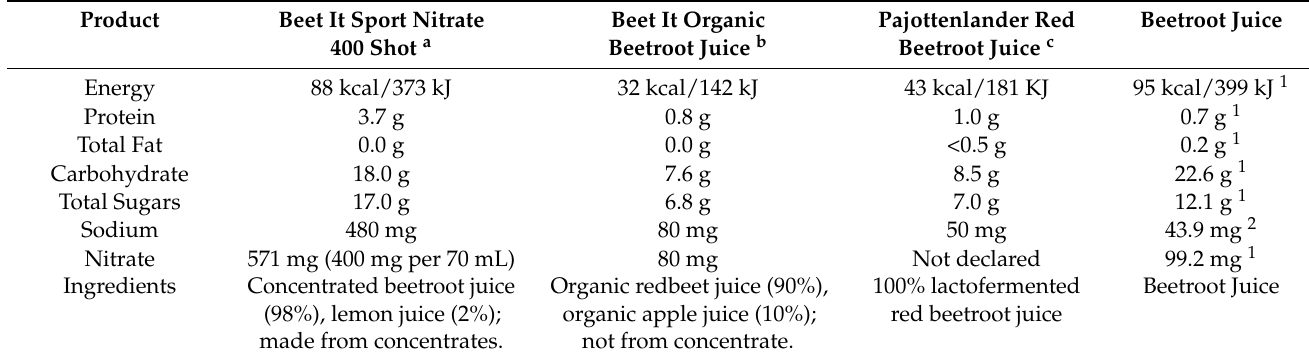
Table 3. Nutritional information panel for beetroot products and beetroot juice. The values are presented in g/100 mL or mg/100